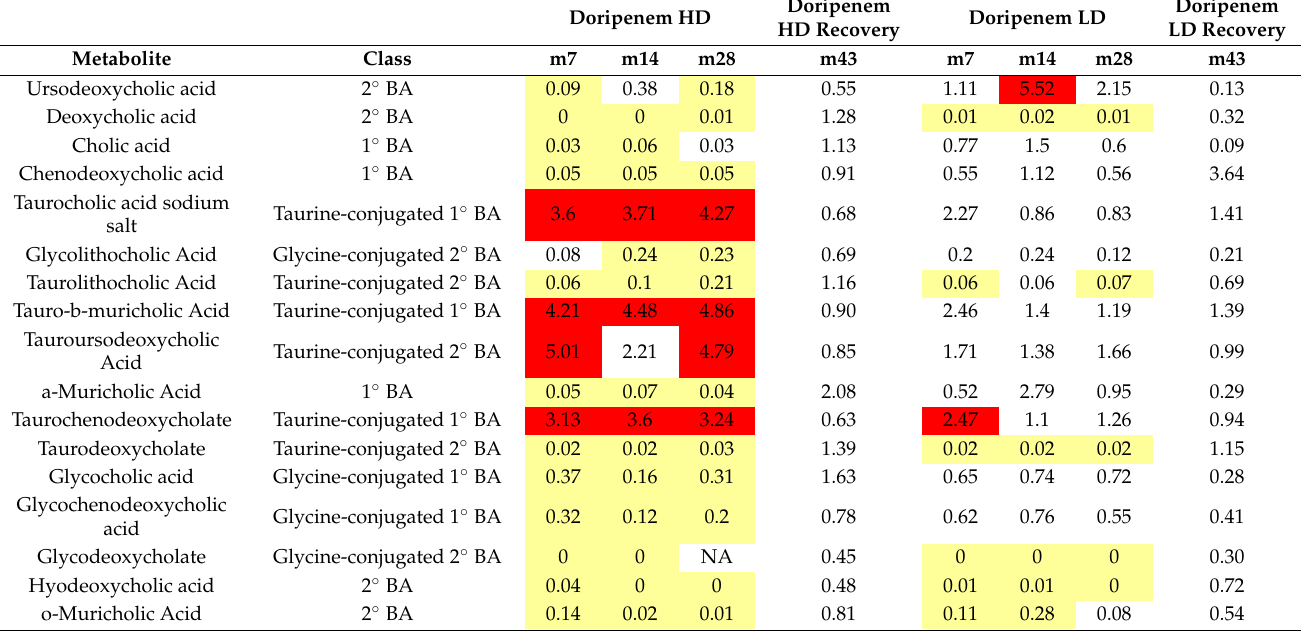
Table 13. Doripenem-induced plasma BA fold changes in male (m) Wistar rats (N = 5 per group) dosed with 100 (LD) and 1000 (HD) mg/kg bw/day observed on days 7, 14, and 28 (m7, m14, and m28) and on day 42 (m42) for the doripenem-recovery group. Statistically significant changes (Welch t -test; p -value < 0.05) are shown where red boxes mean a significant increase, yellow boxes mean a significant decrease, and white boxes indicate an insignificant change in the respective plasma metabolites compared to the control group in the respective plasma